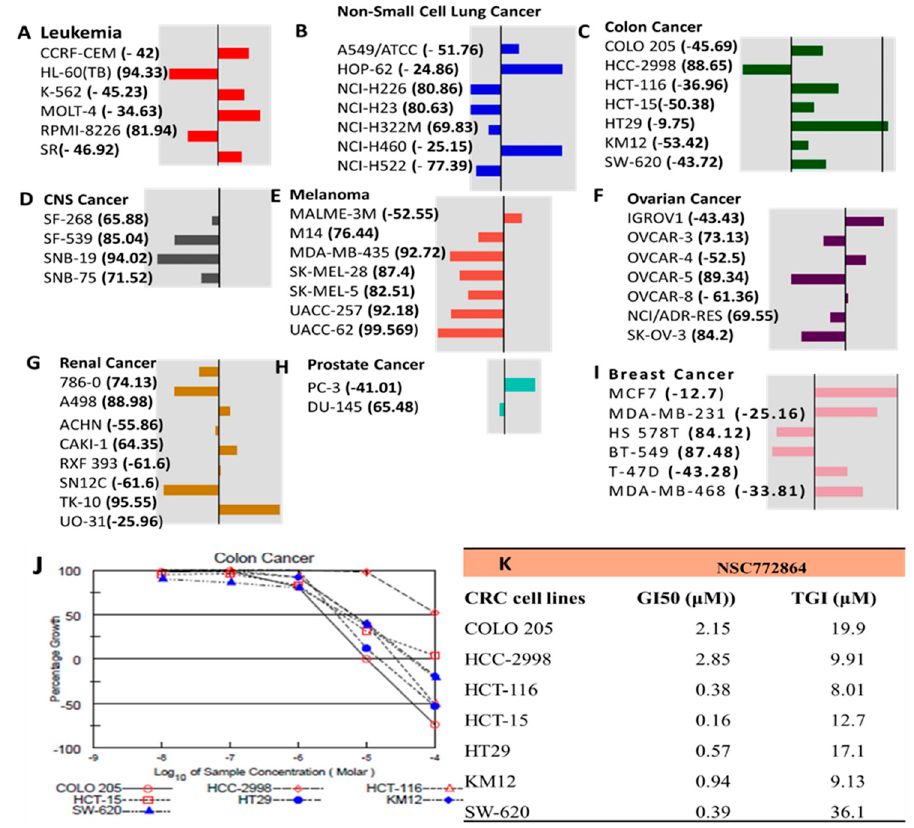
Figure 11. NSC772864 demonstrated anticancer effects in NC-I60 human colon cancer cell lines. ( A – I ) Single-dose treatment administered at 10 μ M revealed growth percentage antiproliferative effects against COLO205, HCC-2998, HCT-116, HCT-15, KM12, and SW620 cells and cytotoxic effects against the HT29 cell line. ( J ) Dose-dependent responses of colon cancer cell lines evaluated using the 50% growth inhibition (GI50) and tumor growth inhibition (TGI). ( K ) In vitro IG50 results ranged from 0.16 to 2.85 μ M in colon cancer cell lines, with HCT-15 being the most responsive at 0.16 μ M, followed by HCT116 at 0.38 μ M, SW-620 at 0.39 μ M, HT-29 at 0.57 μ M, KW12 at 0.94 μ M, and COLO 205 at 2.15 μ M, with HCC-2998 at 2.85 μ M showing the least responsiveness compared to the aforementioned cell lines.